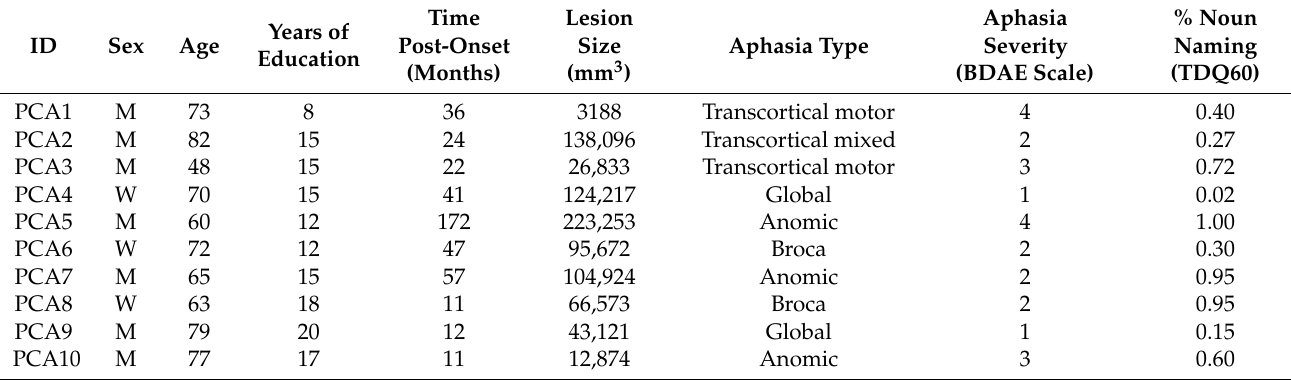
Table 1. Sociodemographic and clinical data for the